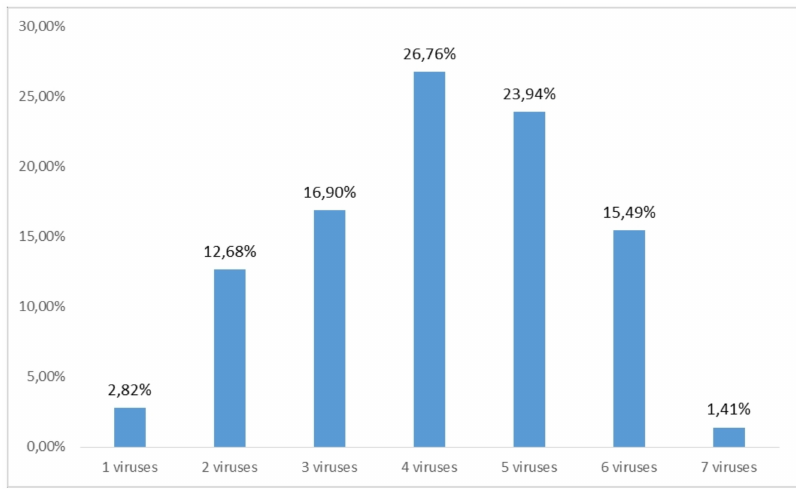
Figure 3. Percentages of single and mixed infections in tested grapevine samples.